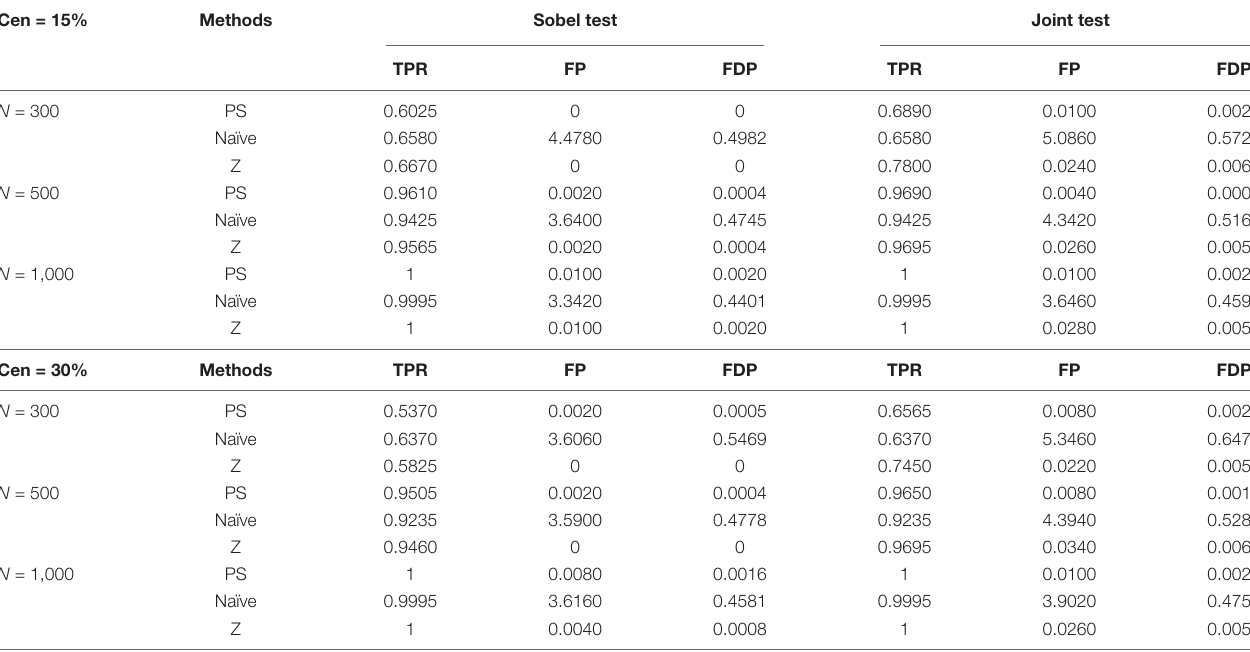
TABLE 1 | Accuracy of mediator selection ( p = 10,000, with 500 replications). Cen = 15%